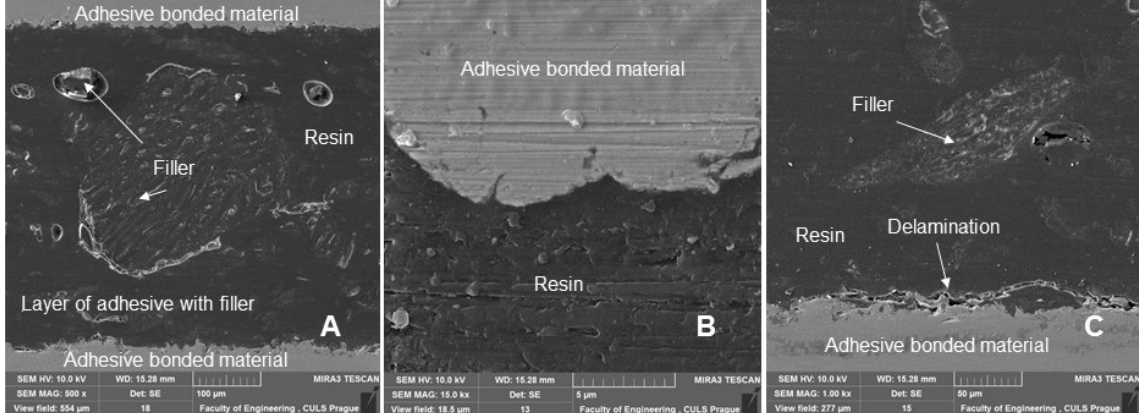
Figure 14. SEM images of an adhesive bond section with a biological filler based on coconut microparticles—designation AB30, quasi-static test from 5 to 50% (157–1567 N), 1000 cycles: ( A ): adhesive bond section (MAG 500 × ), ( B ): section of the adhesive bond with a detailed view of the adhesive layer and the interaction of the bonded material and the composite bonded layer (MAG 15.00 k×), ( C ): section of the adhesive bond with a detailed view of the adhesive layer and the interaction of the bonded material and the composite bonded layer with significant delamination (MAG 1.00 k×).